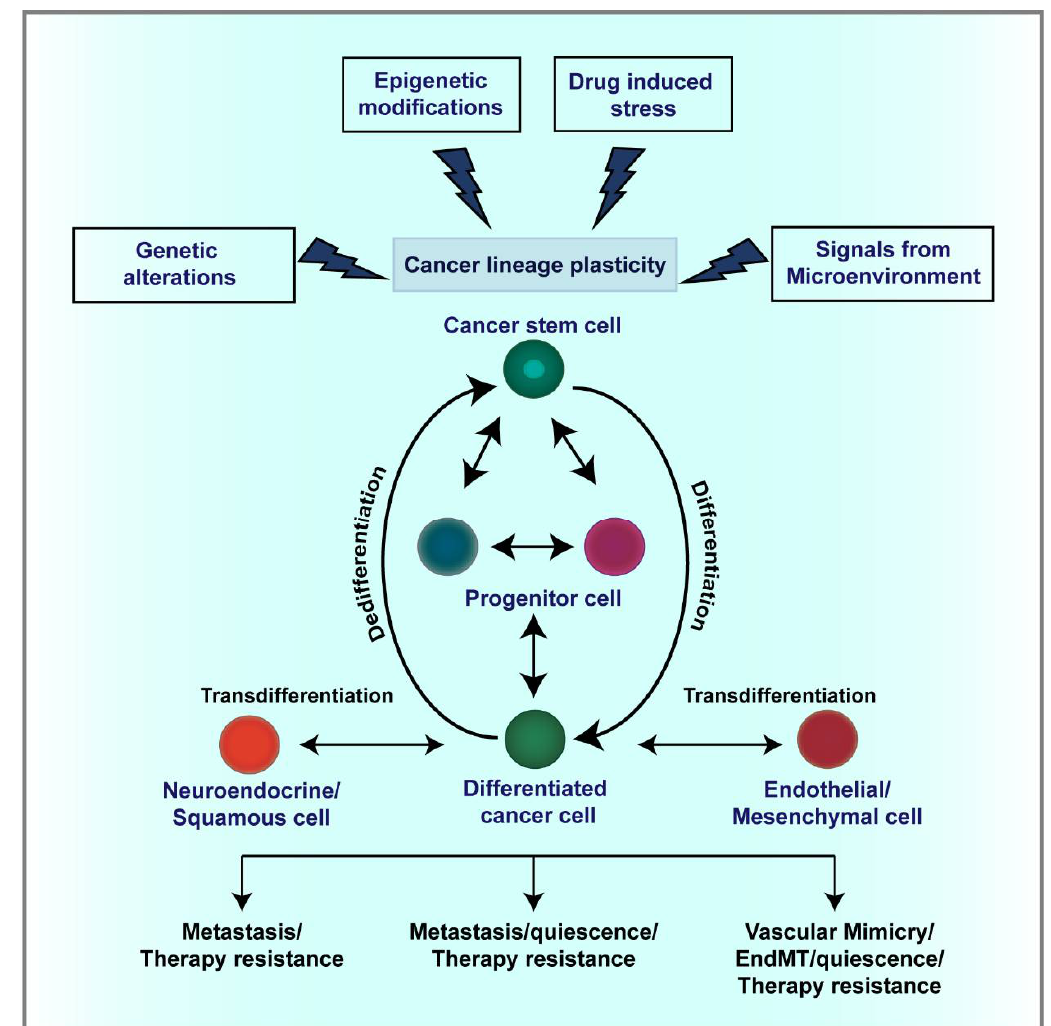
Figure 1. Lineage plasticity promotes tumor progression, therapy resistance and metastasis. Cancer cells can dynamically alter their identity as a result of genetic/epigenetic alterations or in order to adapt to the drug-induced stress and varying microenvironmental cues. This ability, termed as lineage plasticity, enables them to switch between different cell states through processes such as dedifferentiation or transdifferentiation. During dedifferentiation, differentiated cancer cells become less specialized and acquire stem/progenitor cell-like characteristics. Through transdifferentiation, cancer cells can convert from one differentiated lineage to another, i.e., from luminal adenocarcinoma cells to neuroendocrine/small cell or squamous cells as observed in lung, prostate and pancreatic cancer. Cancer cells have also been found to adopt endothelial cell characteristics to form vascular channels through a process called vasculogenic mimicry or mesenchymal phenotype through the process of epithelial-mesenchymal transition. This lineage plasticity is increasingly being recognized as a key player in quiescence, therapeutic resistance and metastasis in cancer.